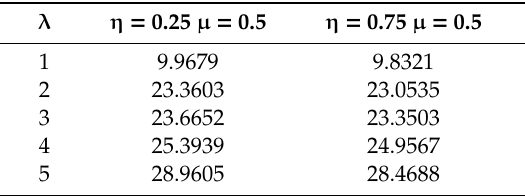
First five natural frequencies for the USFG distribution for two di ff erent states of partial agglomeration. λ